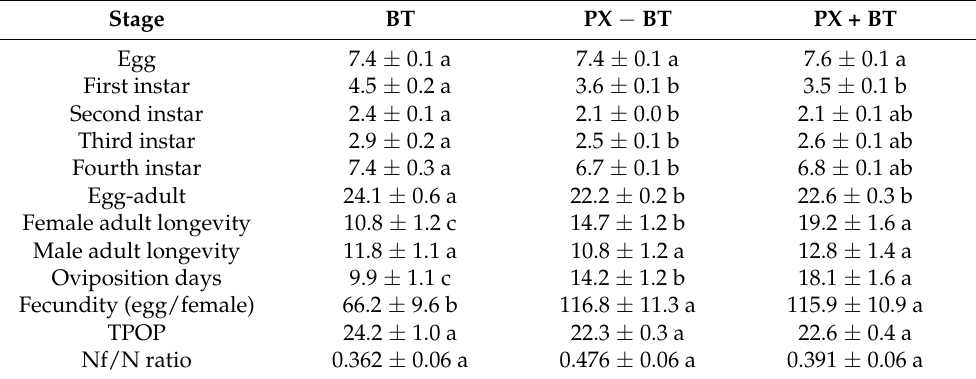
Table 1. Developmental duration and reproduction (M ± SE) of Bemisia tabaci when feeding on Chinese kale alone (BT), with prior DBM damage (PX − BT) or with simultaneous DBM damage (PX + BT).